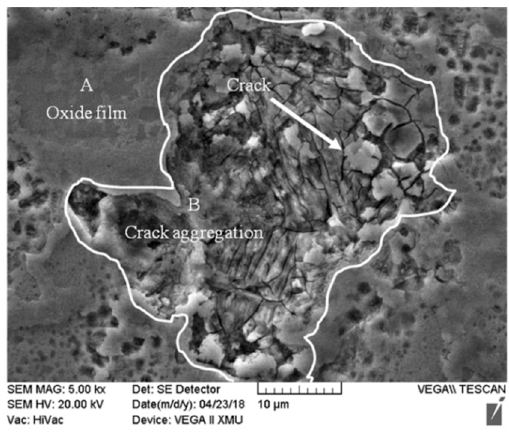
Figure 16. SEM morphology of Ti-6Al-4V titanium alloy after hot corrosion for 88 h.